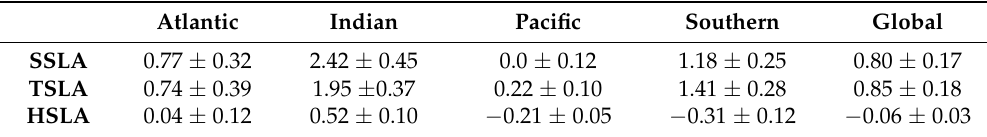
Table 2. Trend of SSLA, TSLA, and HSLA in the mainly ocean basins, unit: mm/yr. Values are ensemble means of all datasets and the two-time standard error.